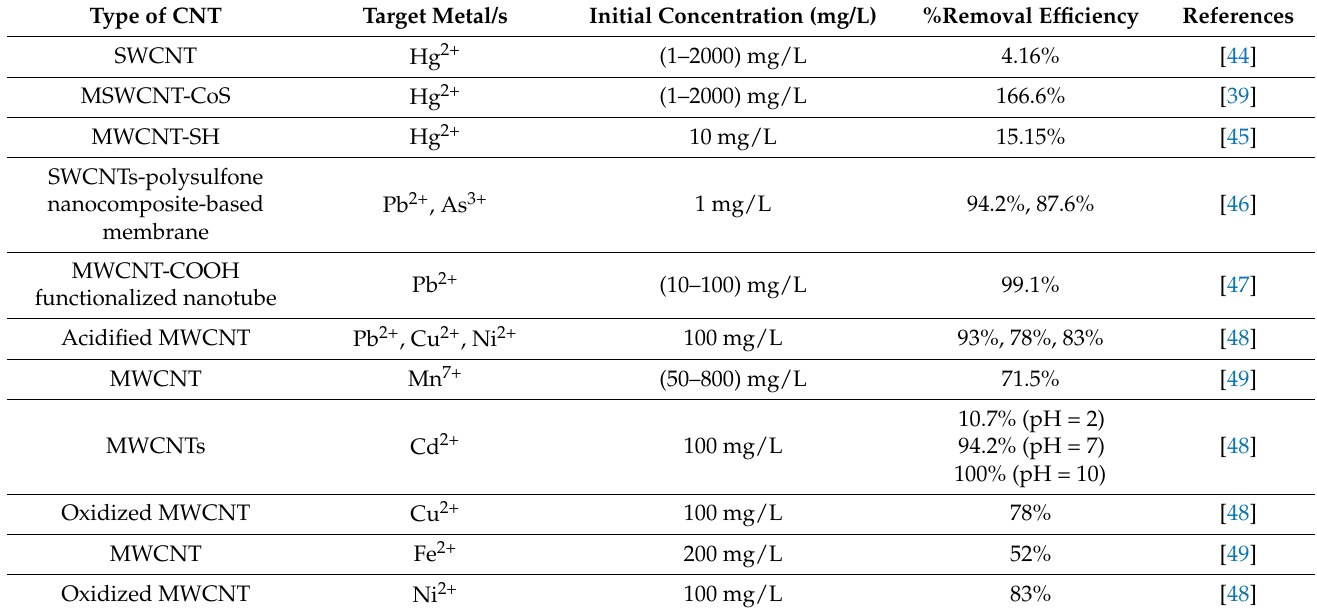
Table 2. Summary of the types of CNT used for the removal of different metallic